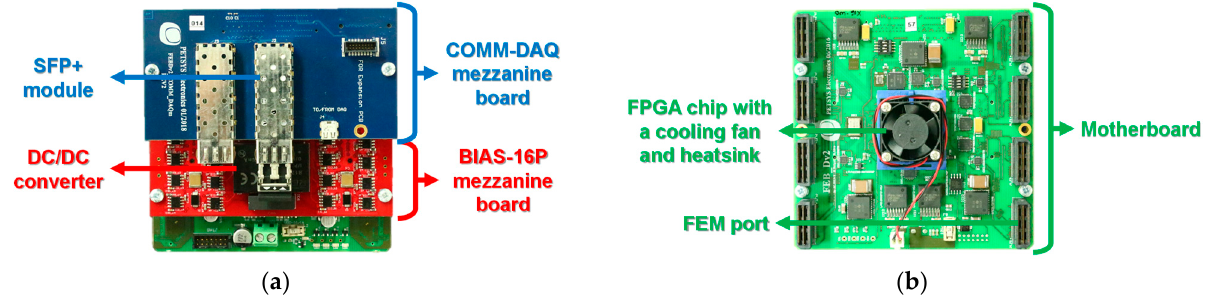
Figure 5. Photographs of FEB/D capable of connecting up to eight FEMs: front ( a ) and back ( b ) views.